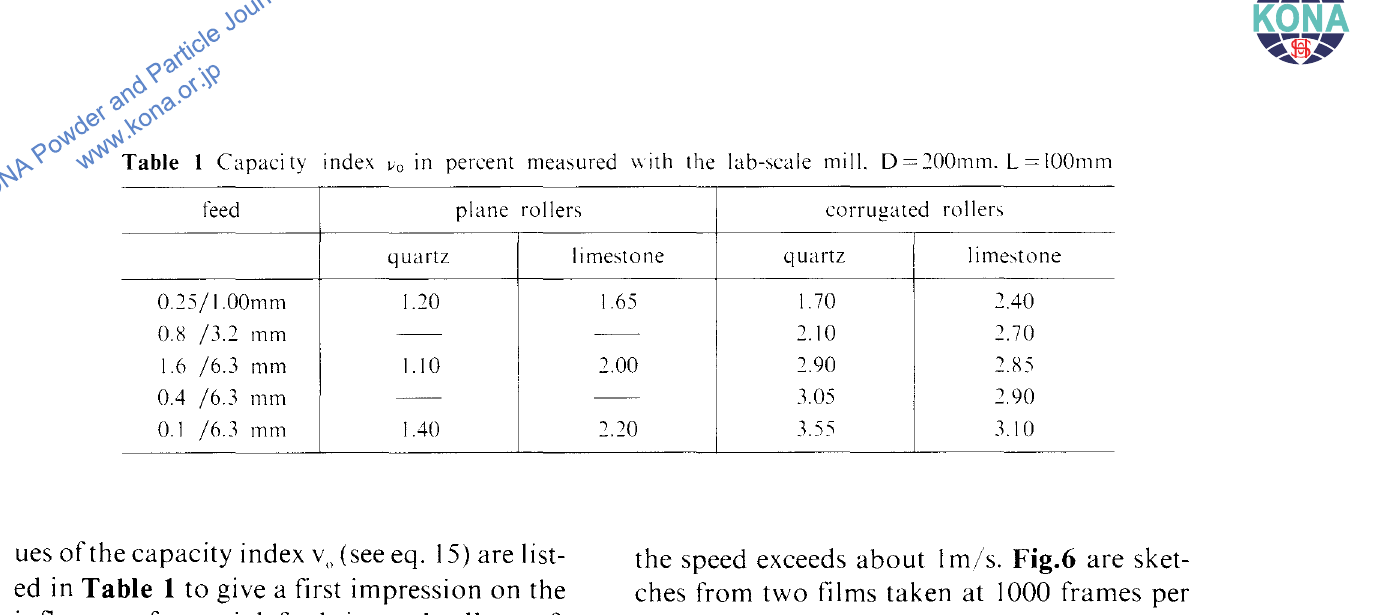
feed plane rollers corrugated